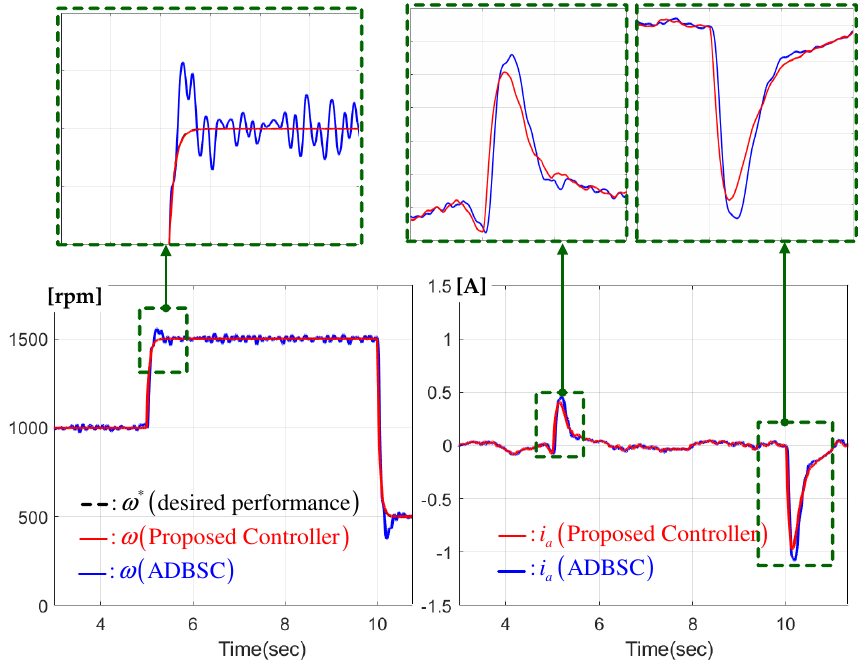
Figure 3. Comparison of speed and stator current responses in stair speed reference tracking